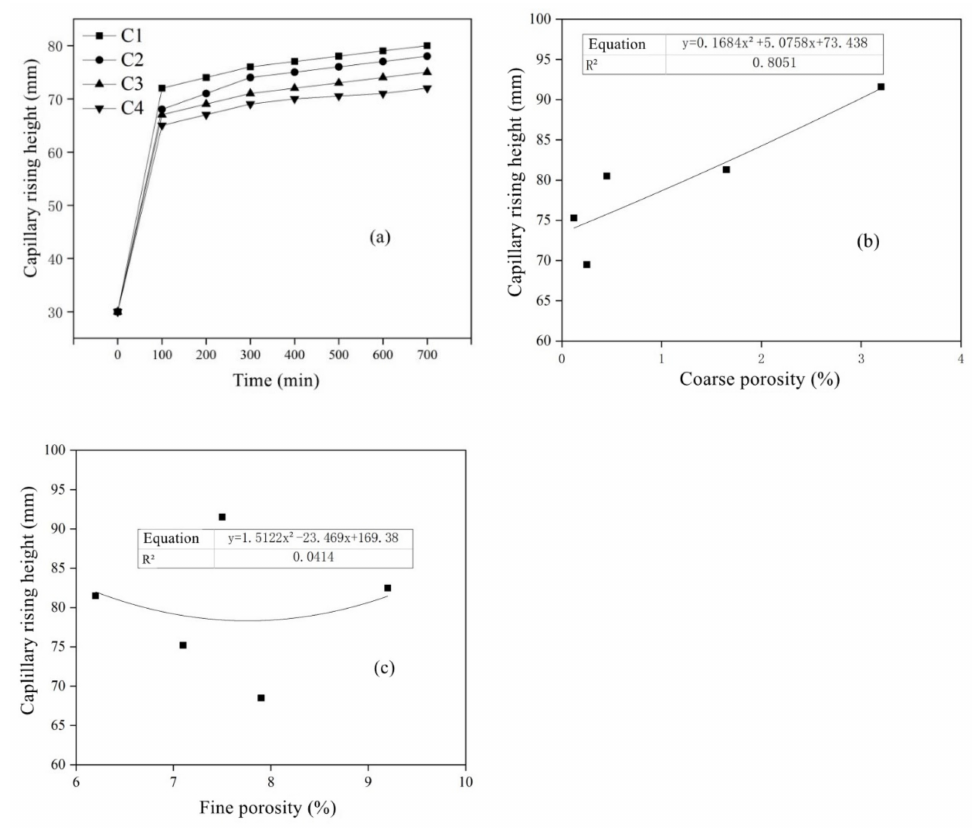
Figure 15. Diagrams of capillary rise height ( a ) versus soaking time, crude porosity ( b ) and system porosity ( c